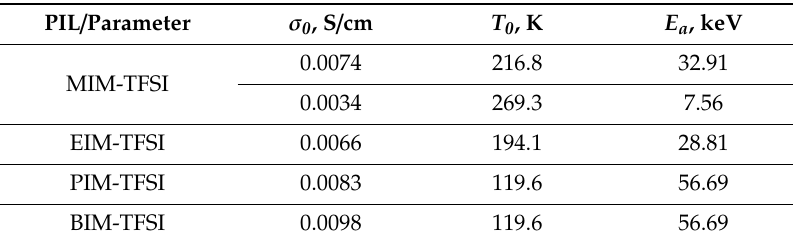
Table 6. Fitted values of the ionic conductivity for the Matrimid ® / PIL membranes according to the VFT equation (Equation